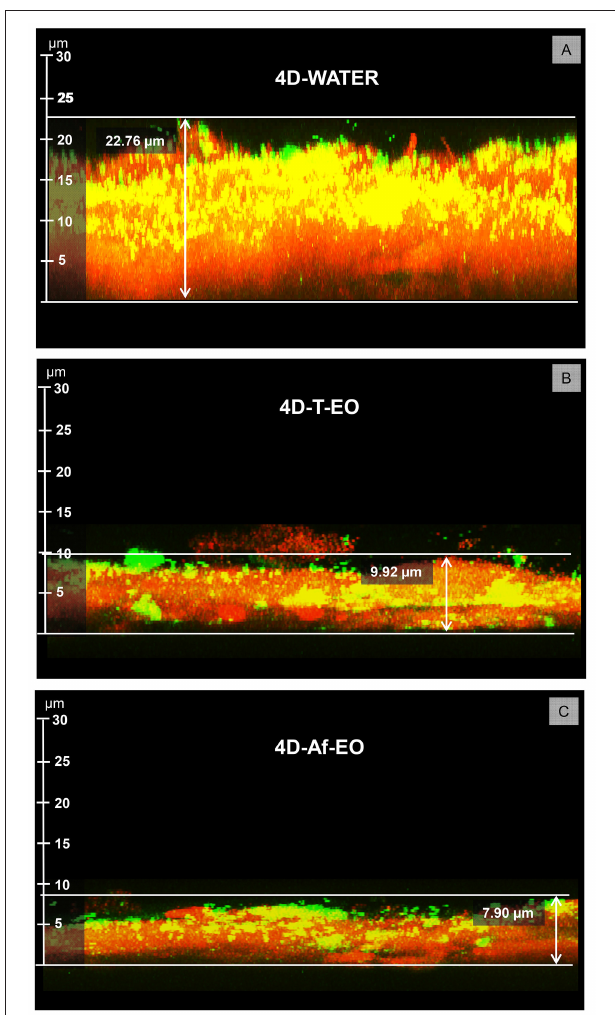
FIGURE 4 | Representative images of the PL-biofilm thickness after 4 days of continuous use of: (A) Sterile water (4D-WATER), (B) Traditional essential oils (4D-T-EO), and (C) Alcohol-free essential oils